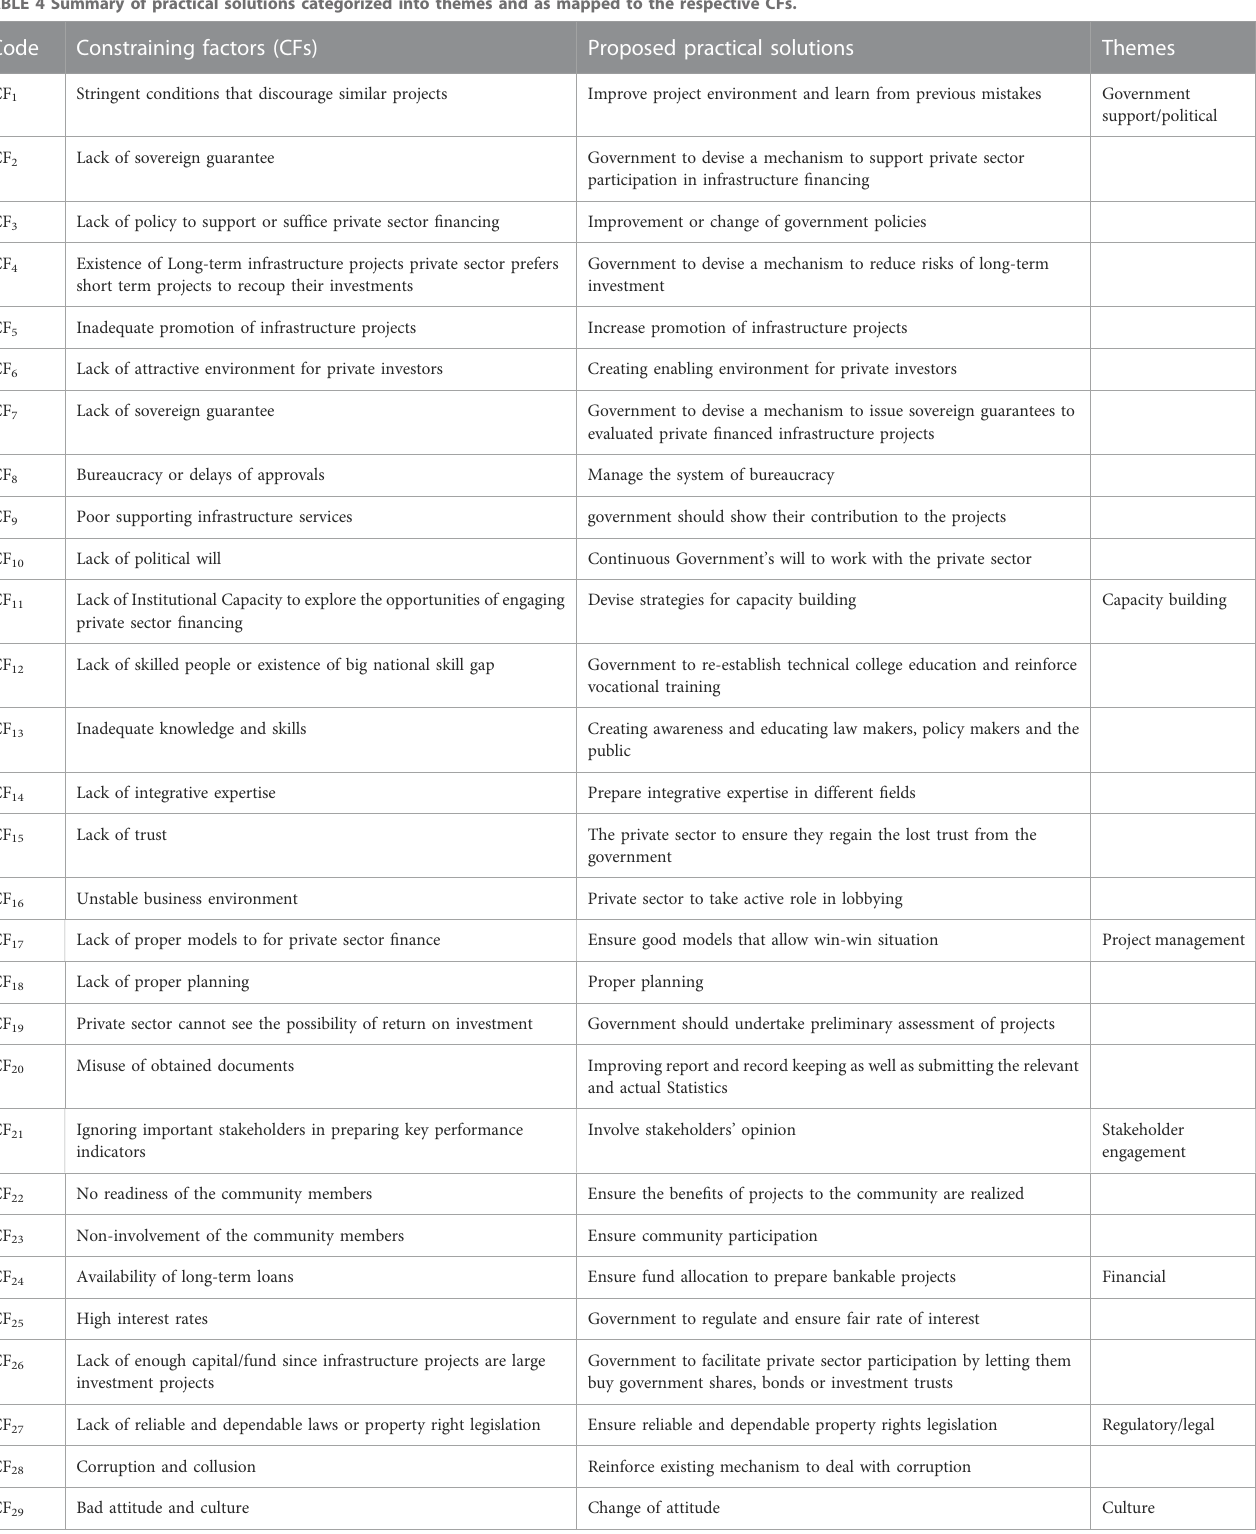
TABLE 4 Summary of practical solutions categorized into themes and as mapped to the respective